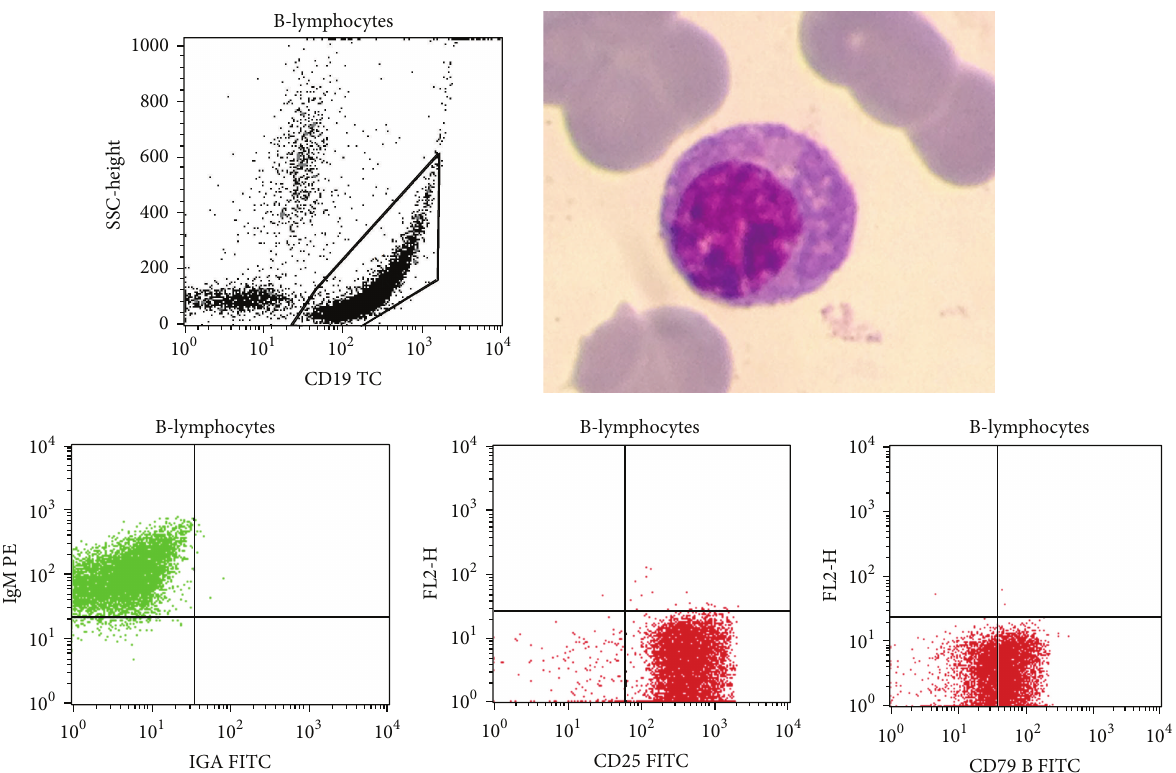
Figure 2: A B-lymphocyte showing a plasmacytic differentiation and selected gated dual parameter dot plots displaying CD19, IgM, CD25, and CD79a.